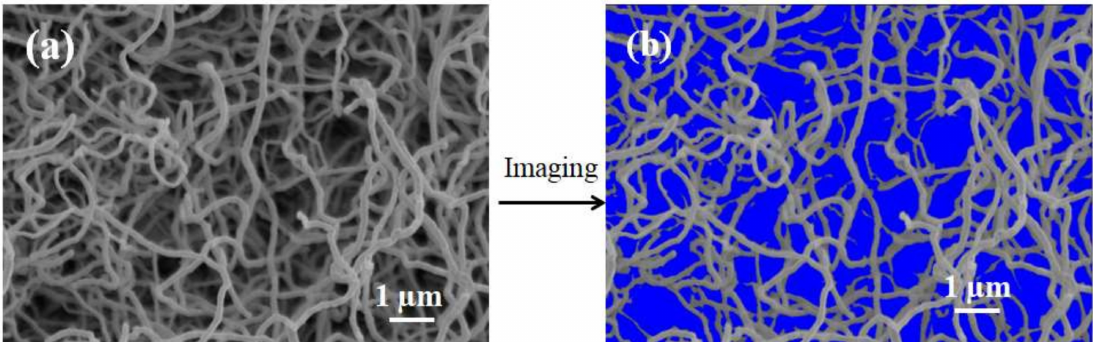
Figure 5. Surface SEM images of the membrane by Image J software (Version:3.4, National Institutes of Health Bethesda, MD, USA) ( a , b ); the blue area in ( b ) denotes surface